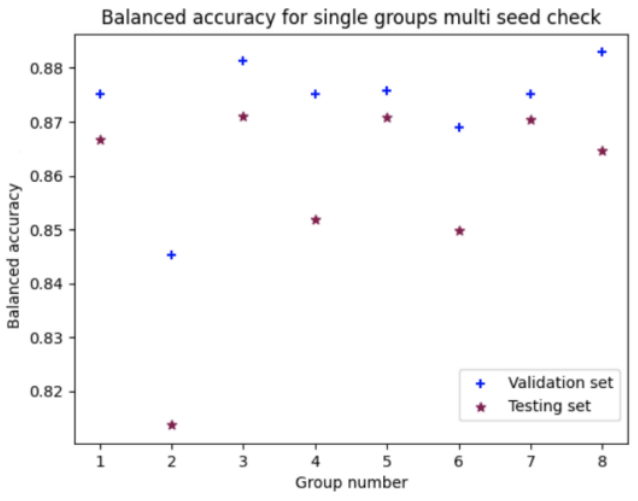
Figure 3. Accuracy of the imPlatelet model when trained only on one of the groups from the KEGG database. The consecutive groups correspond to: (1) metabolism, (2) genetic information processing, (3) environmental information processing, (4) cellular processes, (5) immune system, (6) other organismal systems, (7) cancer, and (8) other human diseases.